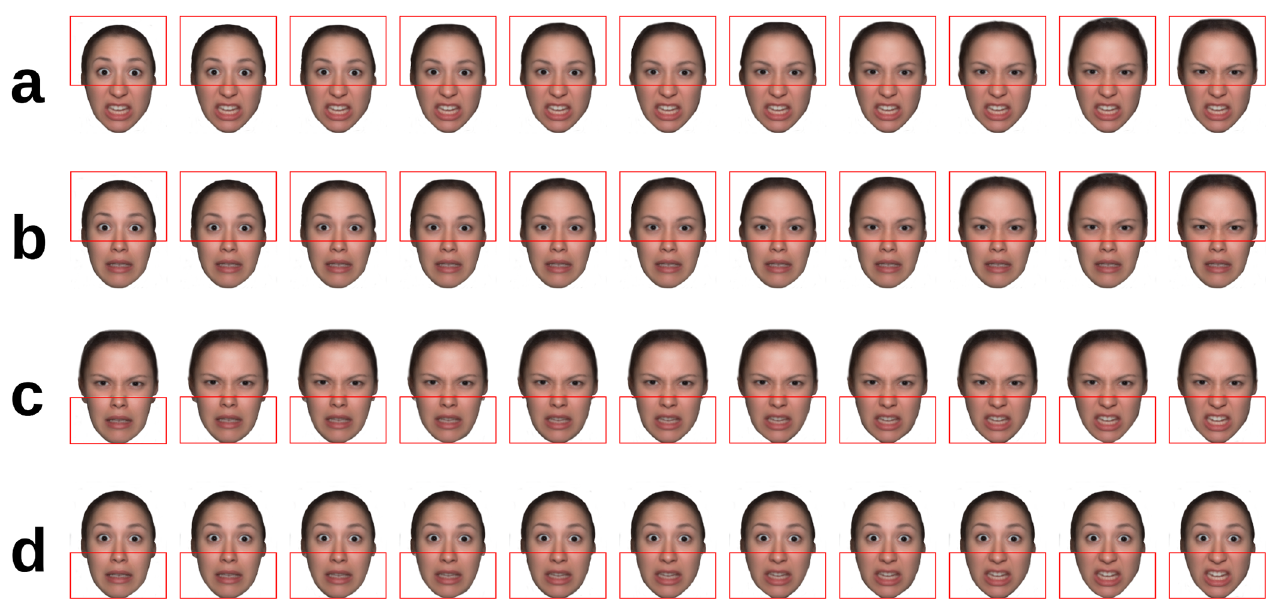
Fig 5. Design of Experiment 2 (Composite Face). Illustration of a face morphed from the original fearful (outer left) to the original angry expression (outer right) in 9 intermediary steps, resulting in a total of 11 face morphs; a, eye judgements with 100% angry lower face half; b, eye judgements with 100% fearful lower half; c, mouth judgements with 100% angry upper face half; d, mouth judgements with 100% fearful upper half; conditions a and b or conditions c and d were always presented in one block, to aid participants in focusing on one face half only; due to copyright restrictions, the depicted example is an in-house generated face which was not used in the present